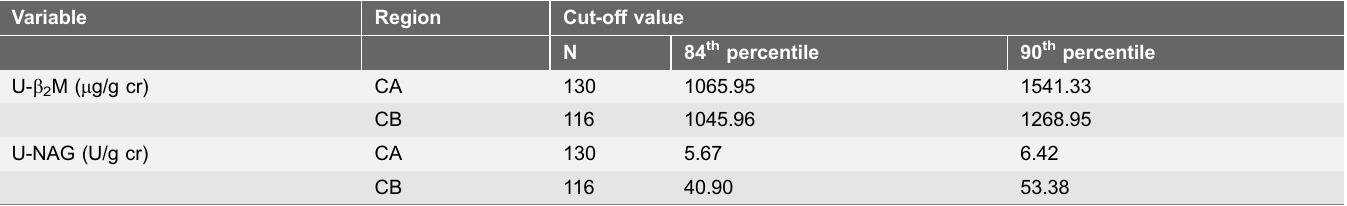
Table 1. Cut-off values of U- b 2 M and U-NAG for subjects in county A (CA) and county B (CB). Variable